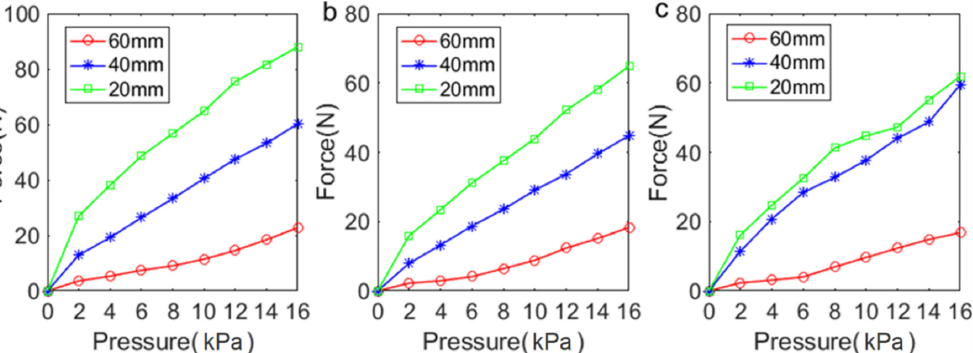
Figure 8. The relationship between maximum pulling forces and input air pressures. ( a ) The maximum pulling force for grasping cylinders with different diameters. ( b ) The maximum pulling force for grasping cuboids with different diameters. ( c ) The maximum pulling force for grasping spheres with different diameters.